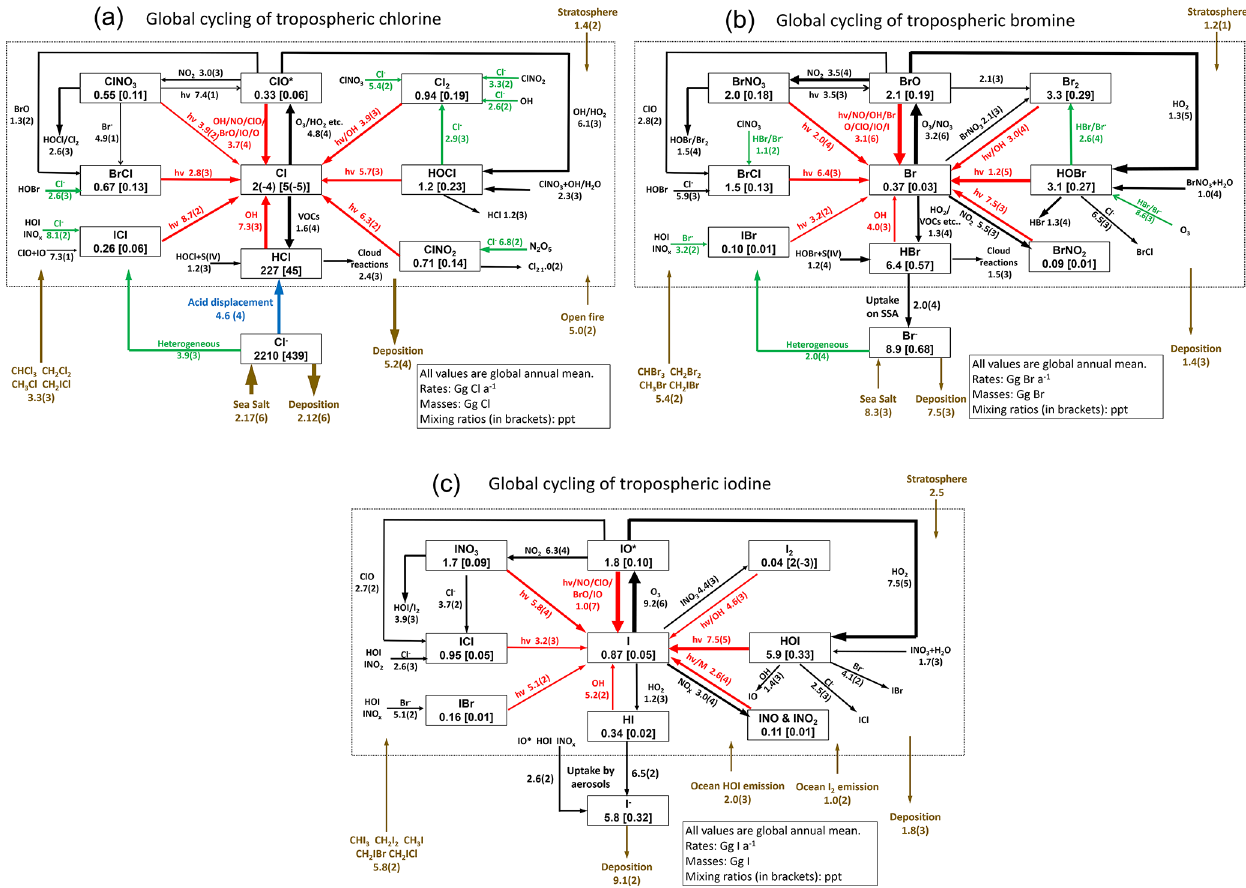
Figure 1. (a) Global budget and cycling of tropospheric inorganic chlorine (Cl y ) in GEOS-Chem. Read 1.0(4) as 1.0 × 10 4 . Reactions producing Cl atoms are in red. Heterogeneous reactions are in green. The dotted box indicates the Cl y family, and arrows into and out of that box represent general sources and sinks of Cl y . Reactions with a rate of < 100GgCla − 1 are not shown. ClO ∗ stands for ClO + OClO + ClO 2 + 2Cl 2 O 2 ; most ClO ∗ is present as ClO. The super-fast Cl–ClOO cycling is not included as it does not affect the Cl atom concentration. (b) Same as (a) but for tropospheric inorganic bromine (Br y ). (c) Same as (a) but for tropospheric inorganic iodine (I y ). IO ∗ stands for IO + OIO + 2I 2 O 2 + 2I 2 O 3 + 2I 2 O 4